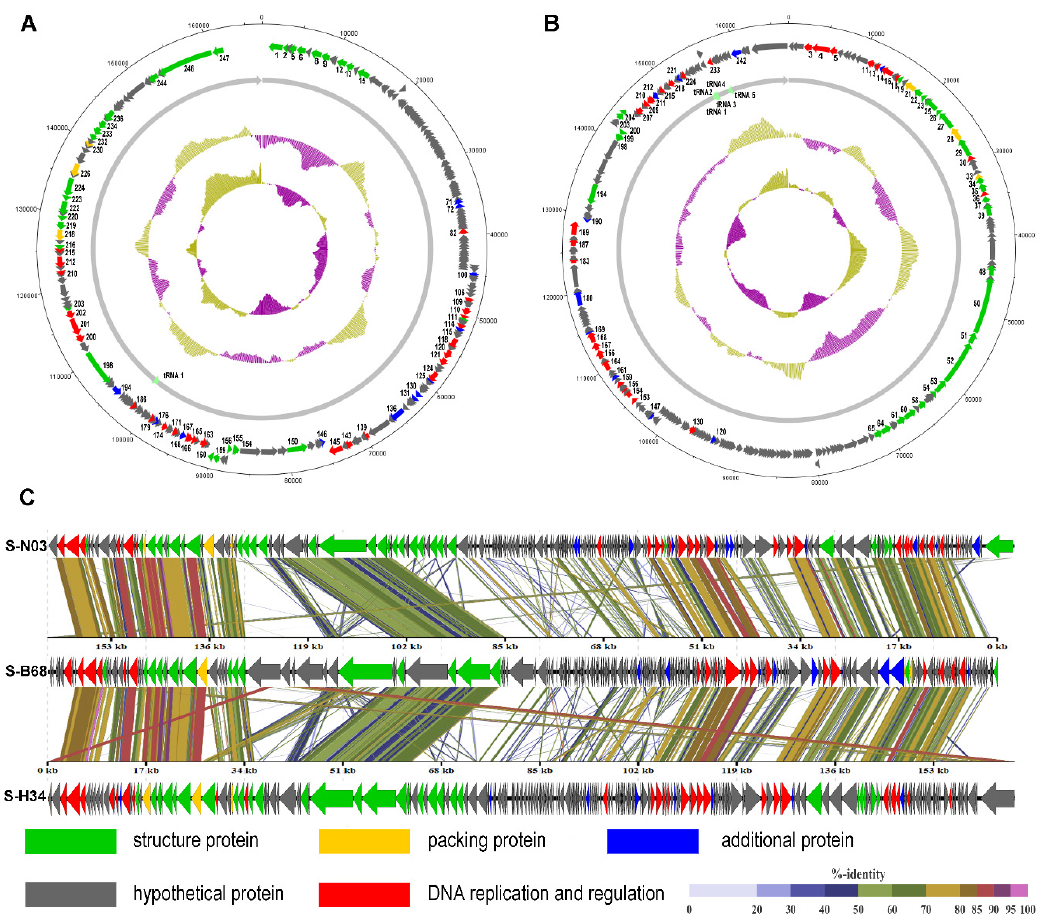
Figure 1. Genome map and functional annotation of the predicted proteins of cyanophage ( A ) S-N03 and ( B ) S-H34. The number next to the arrow indicates the ORF number. ( C ) Genome-wide comparison of phages S-N03, S-H34 and S-B68.